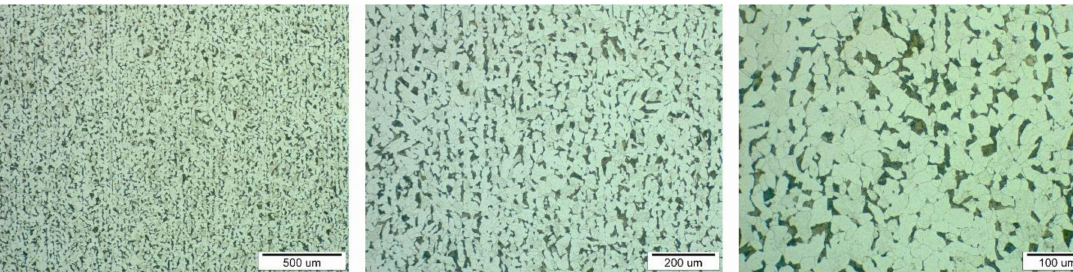
Figure 7. Sample microstructure in longitudinal direction (area A) at three di ff erent magnifications.